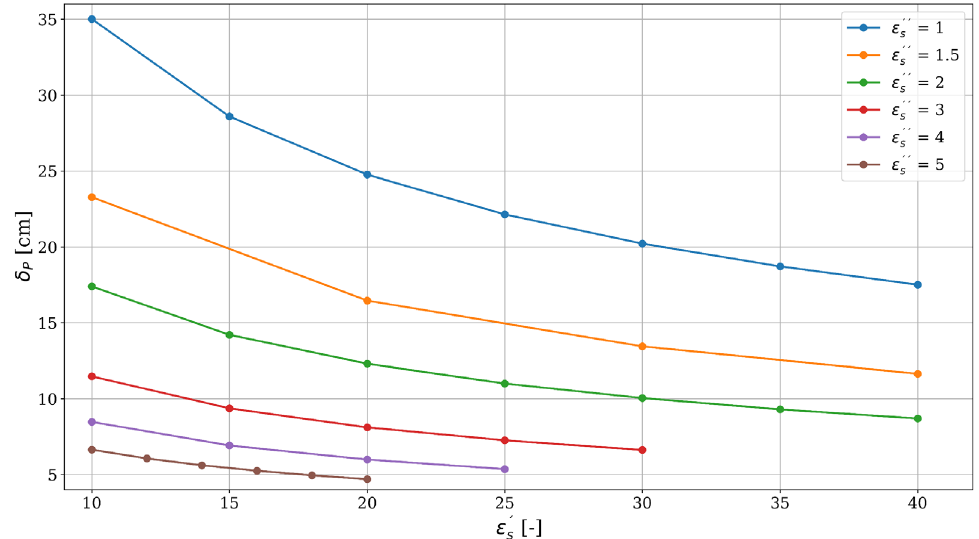
Figure 4. Variations in penetration depth estimates for P-band frequency (430 MHz) along varying real ε (cid:48) s and imaginary ε (cid:48)(cid:48) s parts of complex permittivity based on the formulation from [44,75] (cf. Equation (20)).